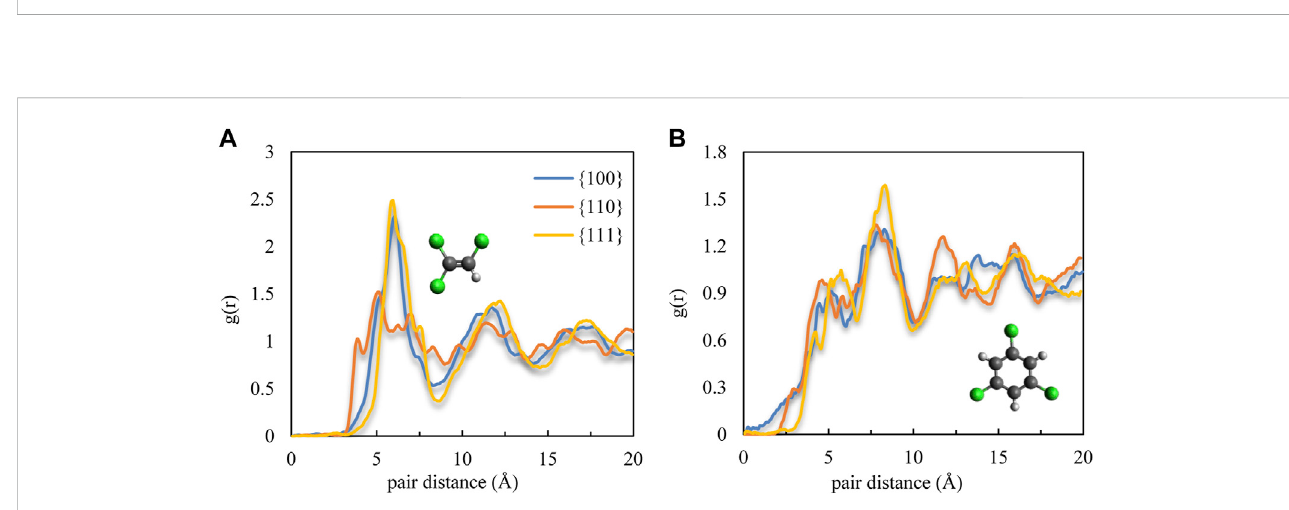
FIGURE 5 Molecular radial distribution g(r) in the adsorption region for (A) TCE at 230 K and (B) TCB at 360 K.